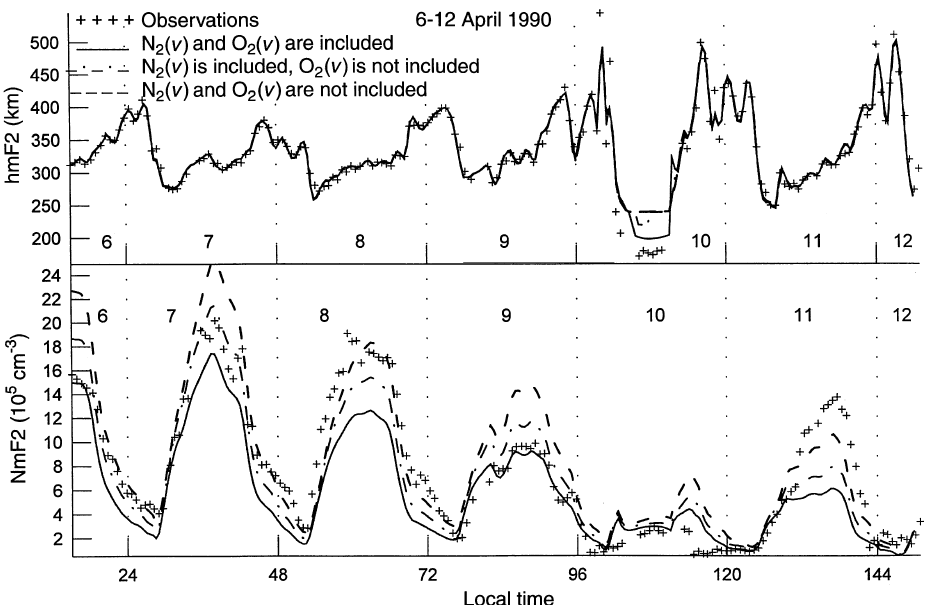
Fig. 5. Observed ( crosses ) and calculated F2 peak parameters above Millstone Hill for the magnetically quiet and disturbed period 6–12 April 1990. Top : hmF2, and bottom : NmF2. The MSIS-86 model with the adjusted atomic oxygen density is used in the IZMIRAN model between 07:00 and 15:00 LT on 10 April at all altitudes. The modeled NmF2 and hmF2 were obtained with e(cid:128)ects of N 2 (cid:133) v (cid:134) and O 2 (cid:133) v (cid:134) using